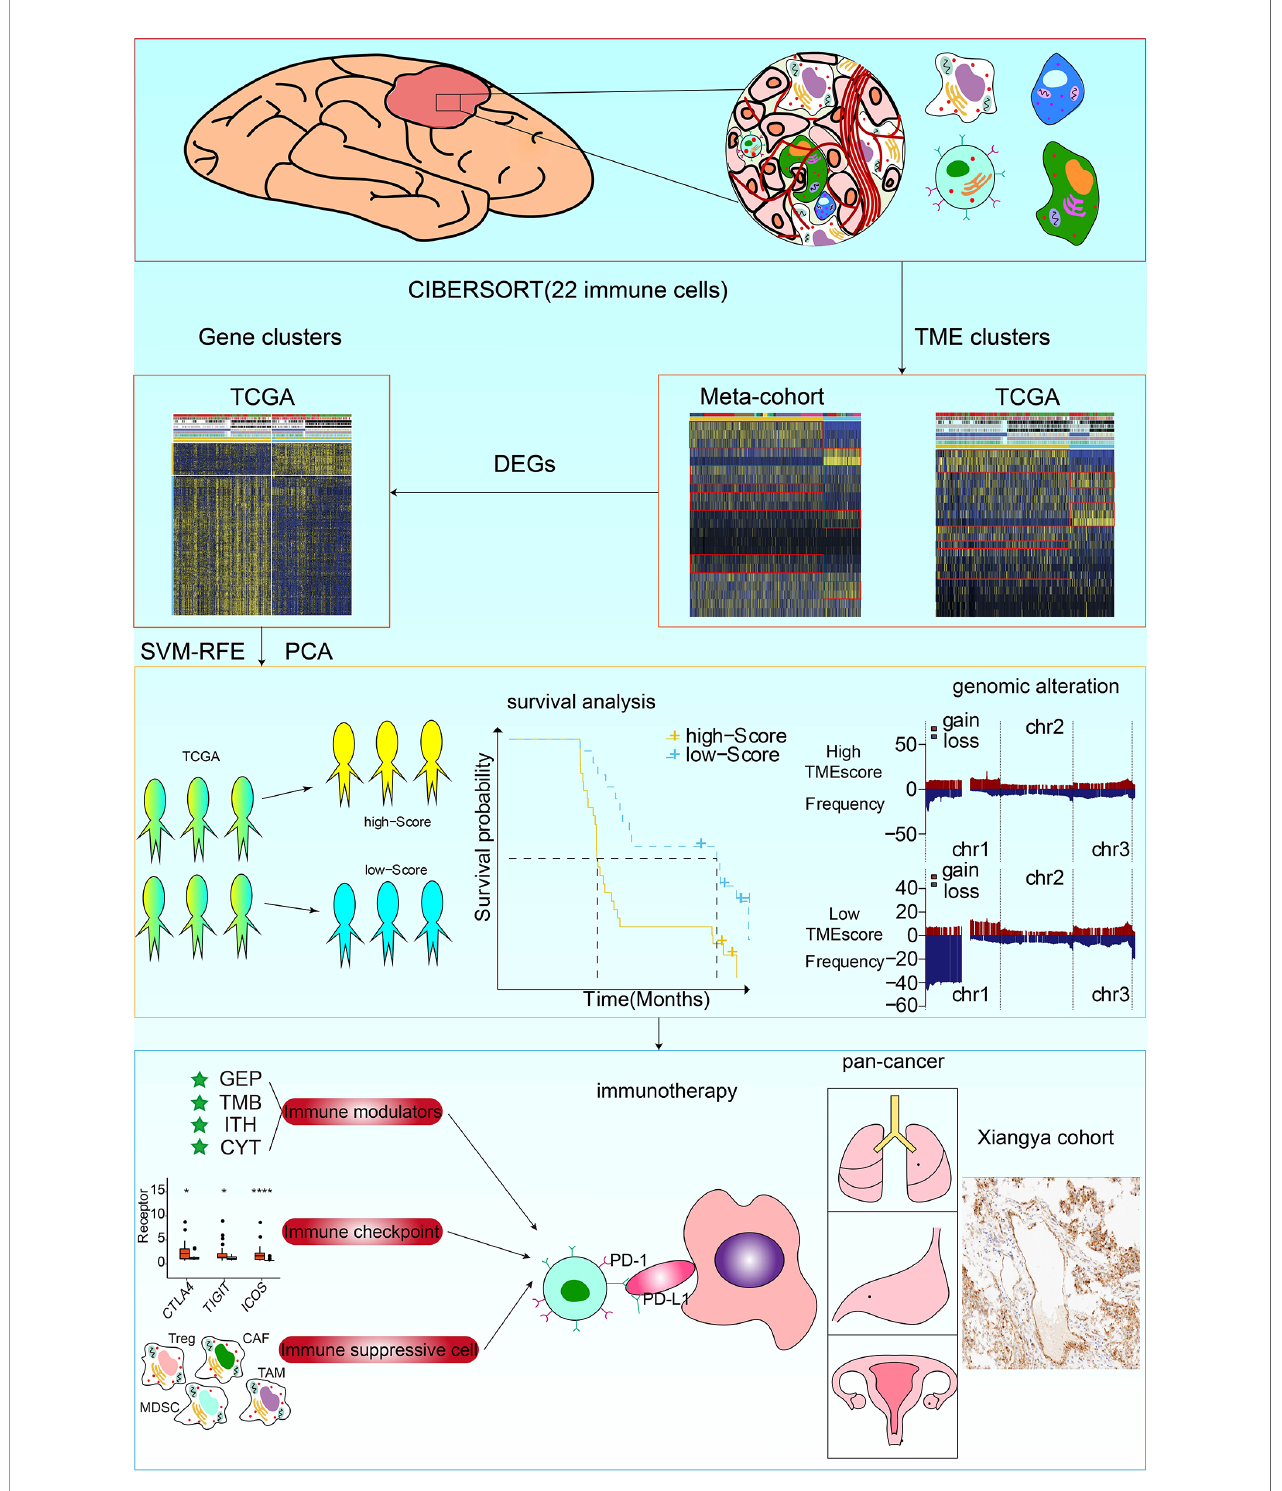
FIGURE 1 | Flow diagram of the study design.TME phenotypes were determined usingthe PartitioningAround Medoid method.Principalcomponent analysis (PCA) was used to construct a TME scoringsystem.A total of 857 glioma samples fromfourdatasets were usedfor external validation of the TME-score. The correlation ofTME phenotypes and TME-scores with diverse clinicopathologiccharacteristics, genomicfeatures, and immunotherapeuticef fi cacy in glioma patients was determined. Immunohistochemistry stainingfor theM2macrophage marker CD68 and CD163 , and RNA sequencing of glioma samples from the XYNS cohort were